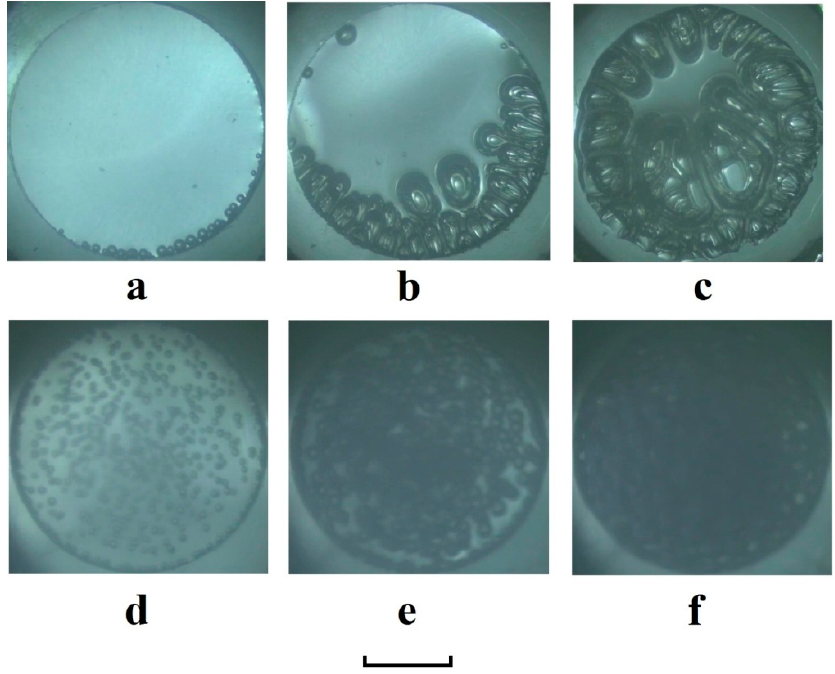
Figure 7. Nucleation and transition to foam expansion in CO 2 -plasticized polylactide depending on the initial pressure (the quasi-isothermal mode; ( a – c )— P ext ( 0 ) = 6.0 MPa; ( d – f )— P ext ( 0 ) = 11.0 MPa). The values of external pressure and time lapse after the start of depressurization: a— P ext ( t ) = 4.8 MPa, t = 400 s; b— P ext ( t ) = 2.7 MPa, t = 660 s; c— P ext ( t ) = 1.8 MPa, t = 960 s; d— P ext ( t ) = 10.1 MPa, t = 180 s; e— P ext ( t ) = 8.3 MPa, t = 400 s; f— P ext ( t ) = 6.8 MPa, t = 610 s. The black bar